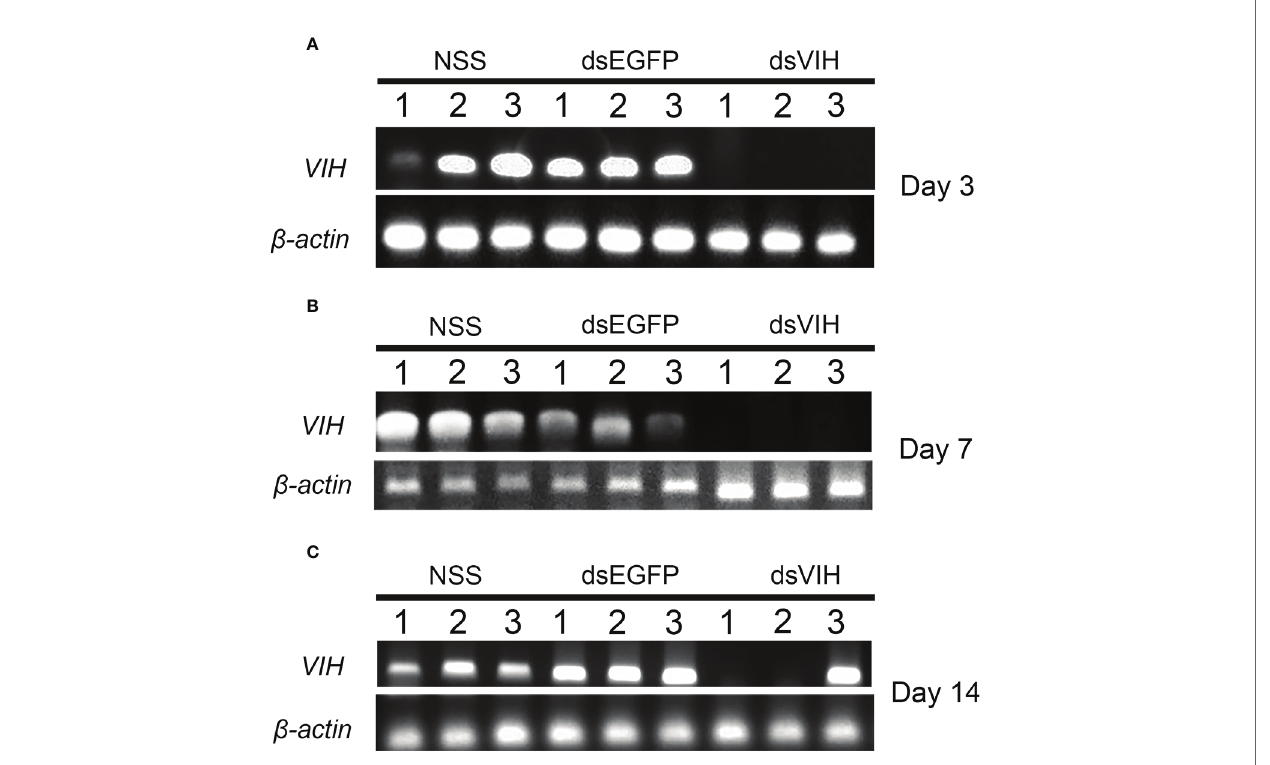
FIGURE 3 | Prolonged effect of the 0.6 m g/g BW of dsRNA-VIH on inhibiting the eyestalk VIH gene expression at day 3 (A) , day 7 (B) and day 14 (C) post-injection. No inhibitory effect on VIH gene expression was observed by the injection of either the dsRNA-EGFP and vehicle control (NSS).